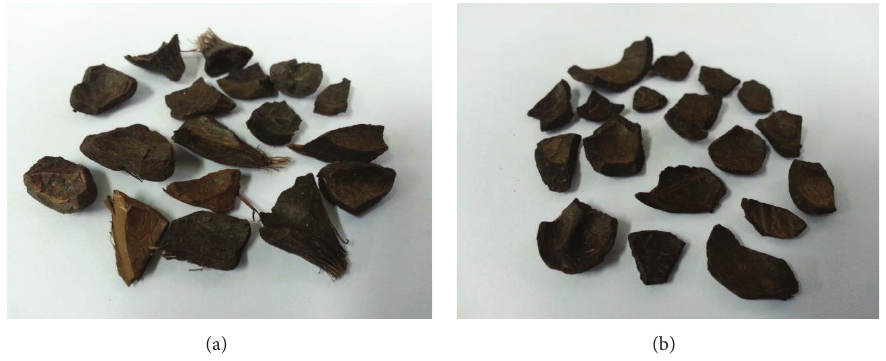
Figure 6: Crushed dura (a) and tenera (b) OPS coarse